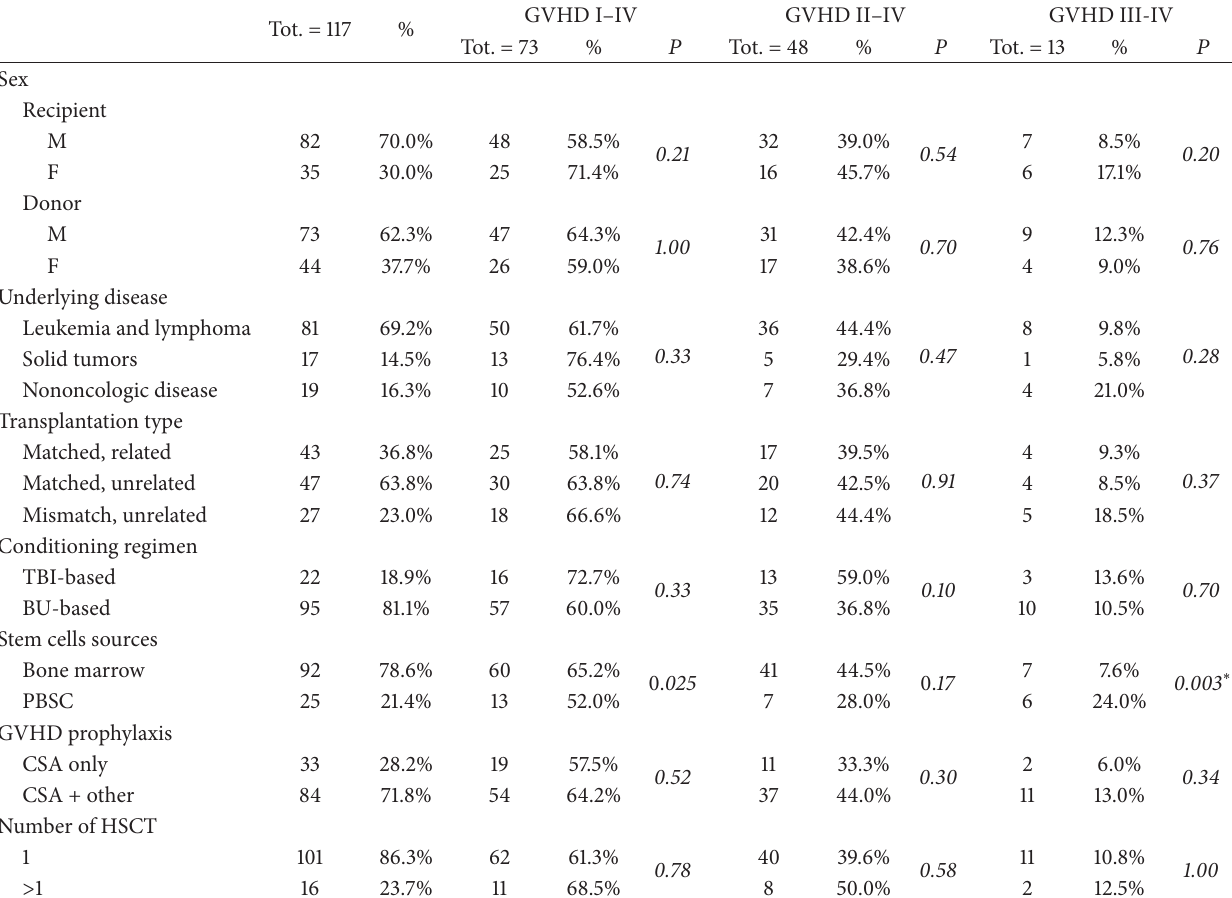
Table 1: Association between clinical variable and